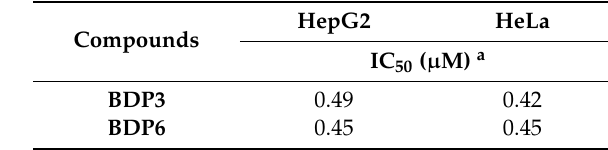
) and in light ( ) (cid:35)